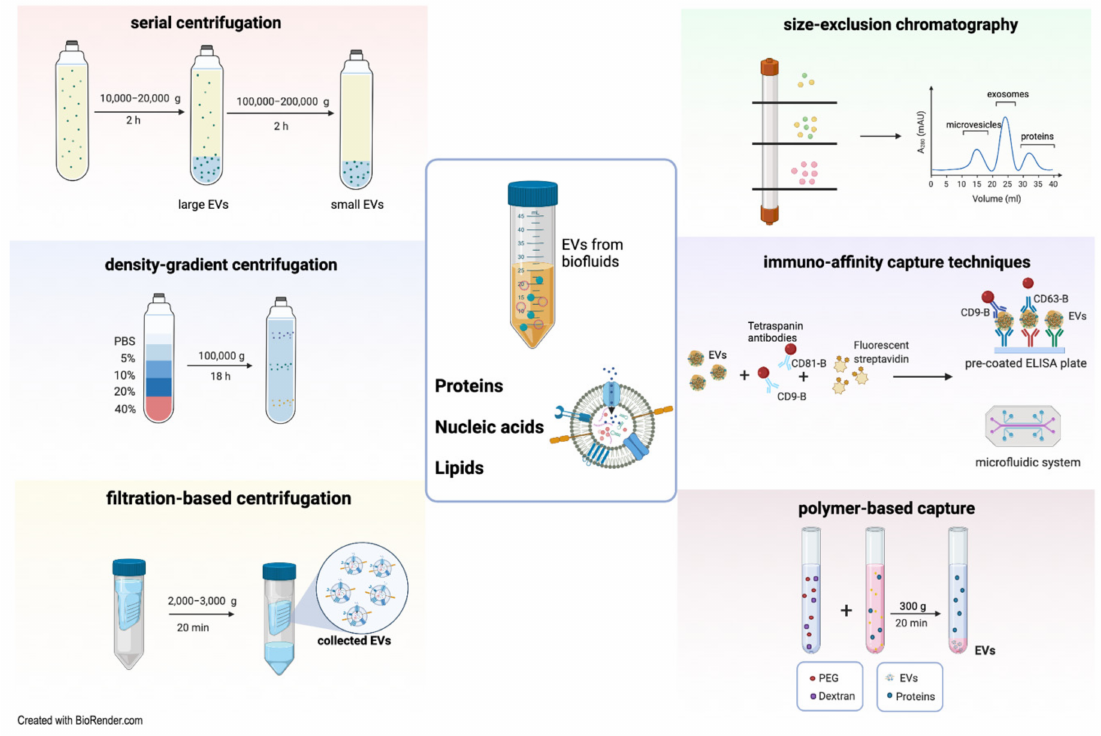
Figure 1. Overview of the most common techniques used for EV isolation from body